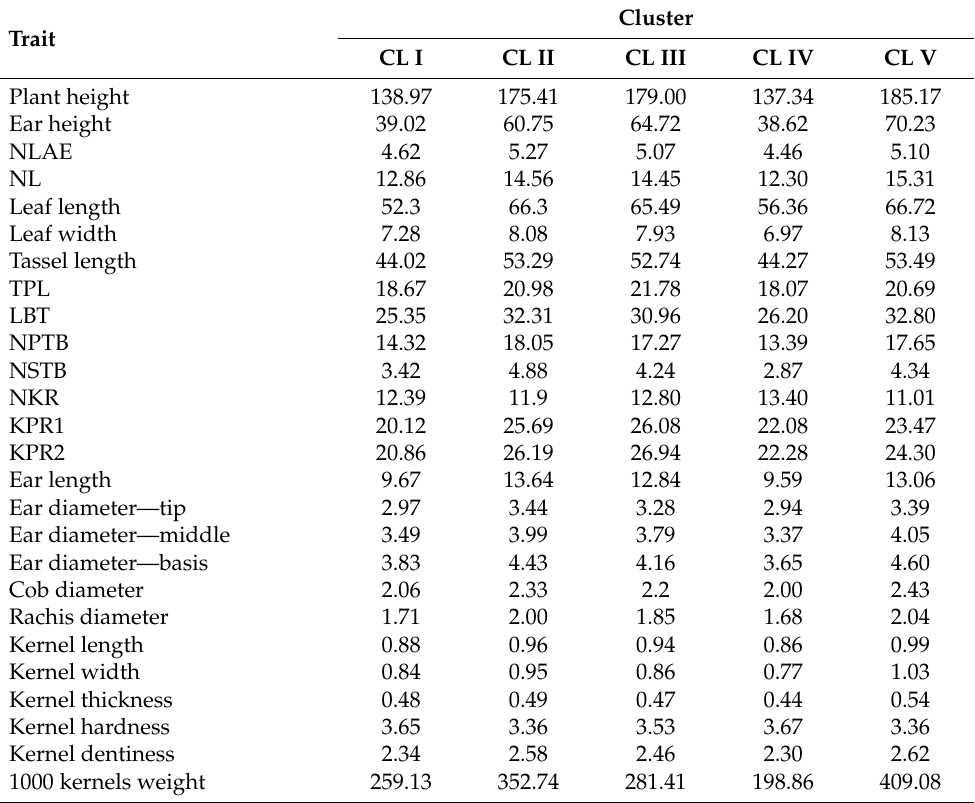
Table 5. Clusters’ mean values of the measured traits for the MRIZPGB yellow-orange maize